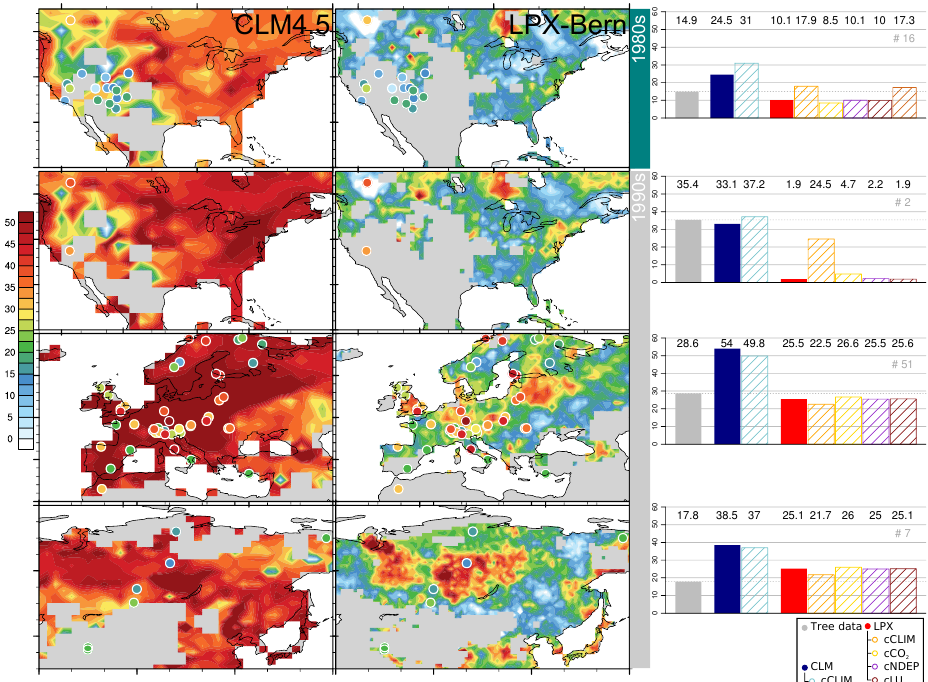
Figure 12. Same as Fig. 11 but for three selected regions. The bar plots show the regional average change in iWUE (%) over all tree-ring measurements (gray) and the average for CLM4.5 (blue) and LPX (red) of the mean grid-cell iWUE of C3 trees and for all model grid cells where tree-ring estimates are available. Individual driving factors (climate, CO 2 , N-deposition, and land use) were kept constant in the factorial runs (patterns), as explained in the main text and indicated by the legend in the bar plots. The number of available records is indicated in each subpanel. All estimates are based on decadal means: (a) 1980s minus 1900s; (b, c, d) 1990s minus